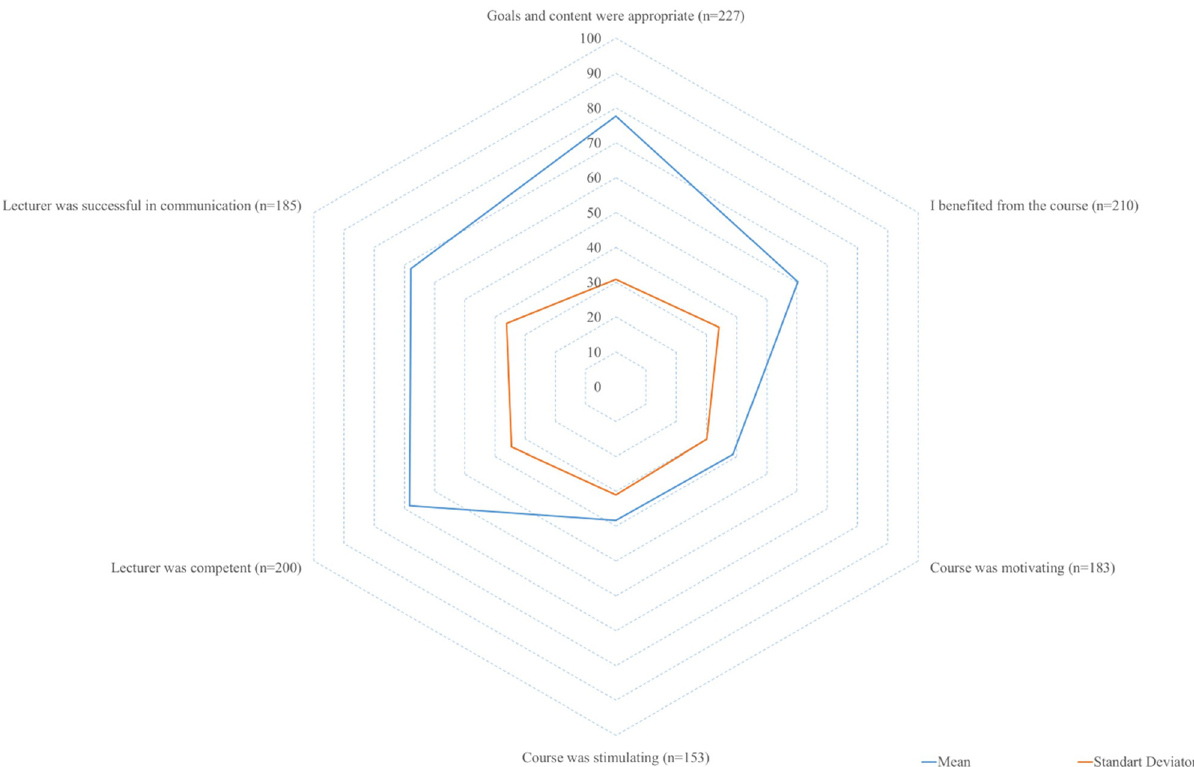
Figure 2: The radar chart of evaluation domain